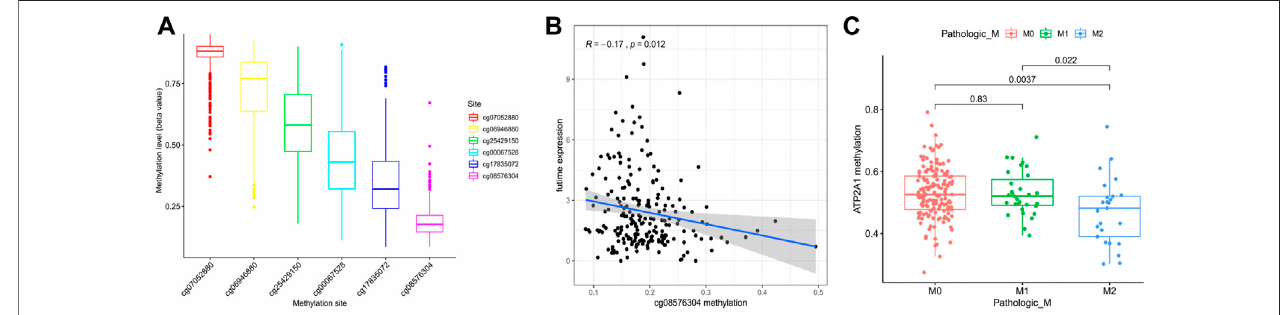
FIGURE 3 | Regulation of methylation level on ATP2A1 expression. (A) The methylation level of six ATP2A1 DNA promoter CpG sites. (B) The expression of ATP2A1 is negtively related with the methylation of cg08576304. (C) Correlationship between ATP2A1 methylation level and pathologic M (M2 vs. M0, p = 0.0037; M2 vs. M1, p = 0.022).